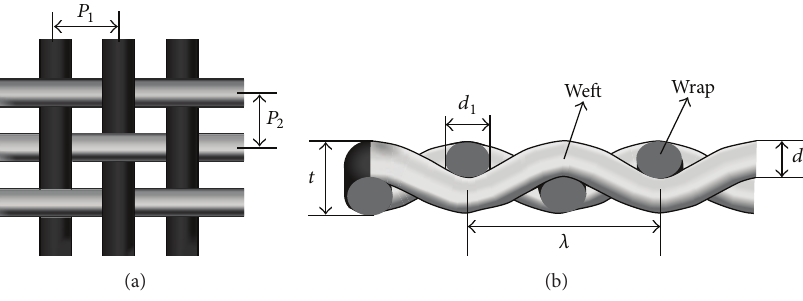
Figure 1: Plain woven fabric: (a) top view and (b) cross section view